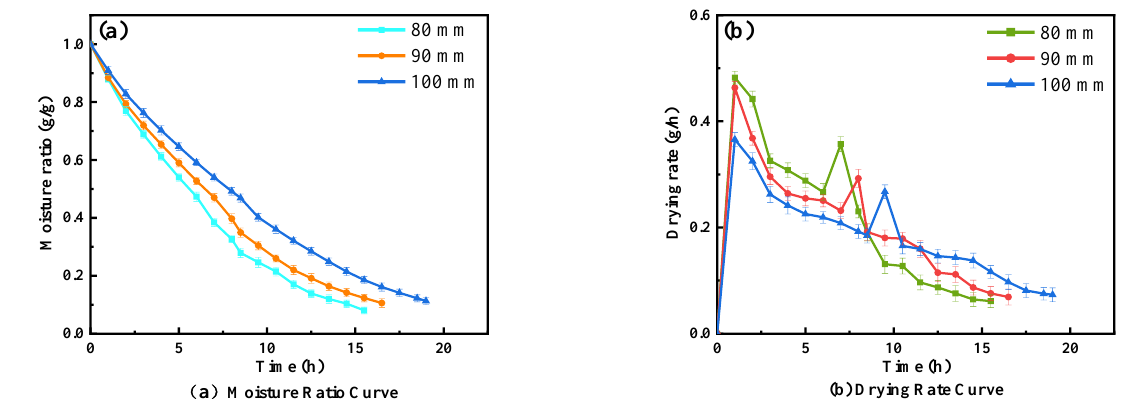
Figure 2. Effects of different plate spacing on drying characteristics.